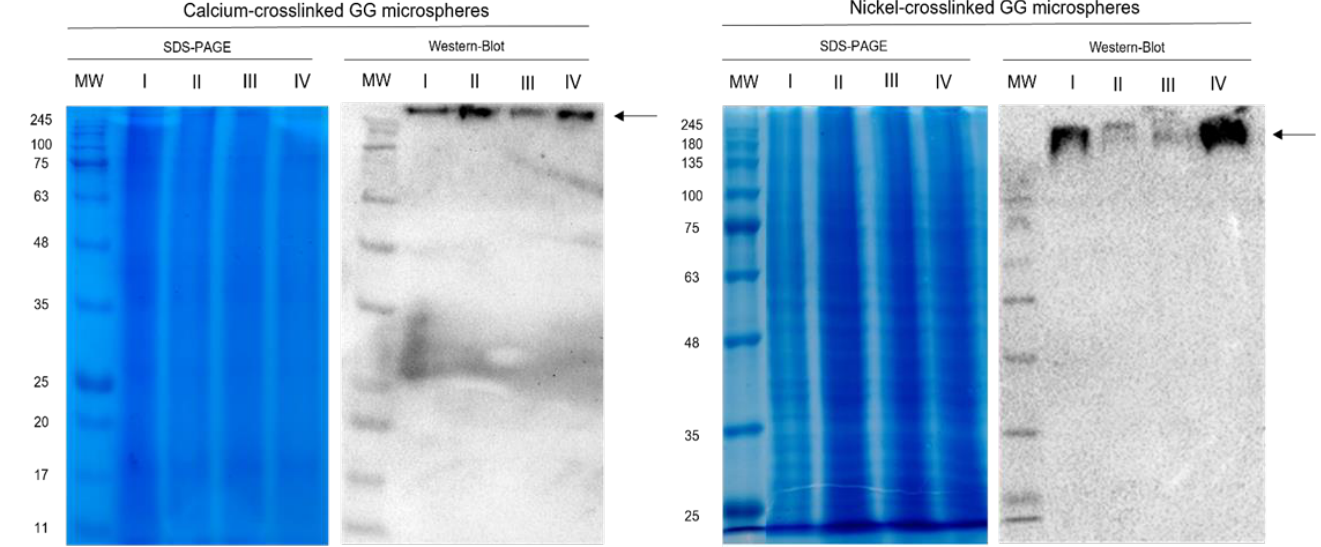
Figure 3. SDS-PAGE and Western blot of the recovered supernatants from the initial batch for both calcium- and nickel-crosslinked microspheres (35 mL GG microspheres for both ions represented). MW — molecular weight; I — sample that did not bind to GG microspheres at 10 mM MES pH 6.2; II — washing step with 10 mM Tris pH 8; III — elution step with 10 mM Tris pH 9.2; IV — elution step with 10 mM Tris pH 11; arrows indicate STEAP1 complexes.